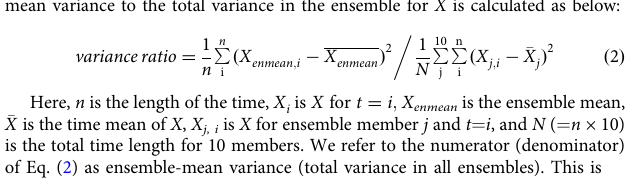
we calculate the ensemble mean and standard deviation in each year, and the ensemble mean and quartiles of linear trends for 1970 – 2017. This calculation is repeated 1000 times to obtain the average statistics. Time series and box-whisker plots shown in Fig. 1 represent the average and range of “ statistics from ten members ” for HIST and these are compared to single “ statistics from ten members ” for NAGA. Note that this Monte Carlo method is used to calculate the time series and the box-plot in Fig. 1. For the other analyses, only 10 HIST members that correspond to NAGA are used. Ratio of the ensemble mean variance to all variances . The ratio of ensemble- mean variance to the total variance in the ensemble for X is calculated as below: (cid:4) 1 1 ð ð X (cid:1) X Þ 2 ∑ n varianceratio ¼ 2 Þ enmean ; i enmean n i Here, n is the length of the time, X i is X for t ¼ i ; X enmean is the ensemble mean, (cid:1) X is the time mean of X , X = i , and N ( = n × 10) j, i is X for ensemble member j and t is the total time length for 10 members. We refer to the numerator (denominator) of Eq. (2) as ensemble-mean variance (total variance in all ensembles). This is